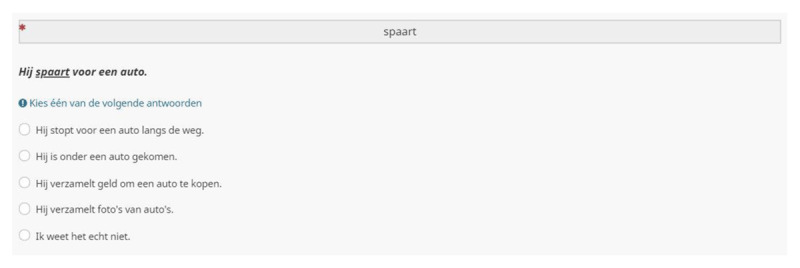
Receptive multiple choice test (Andringa et al., 2012); example item set-up.